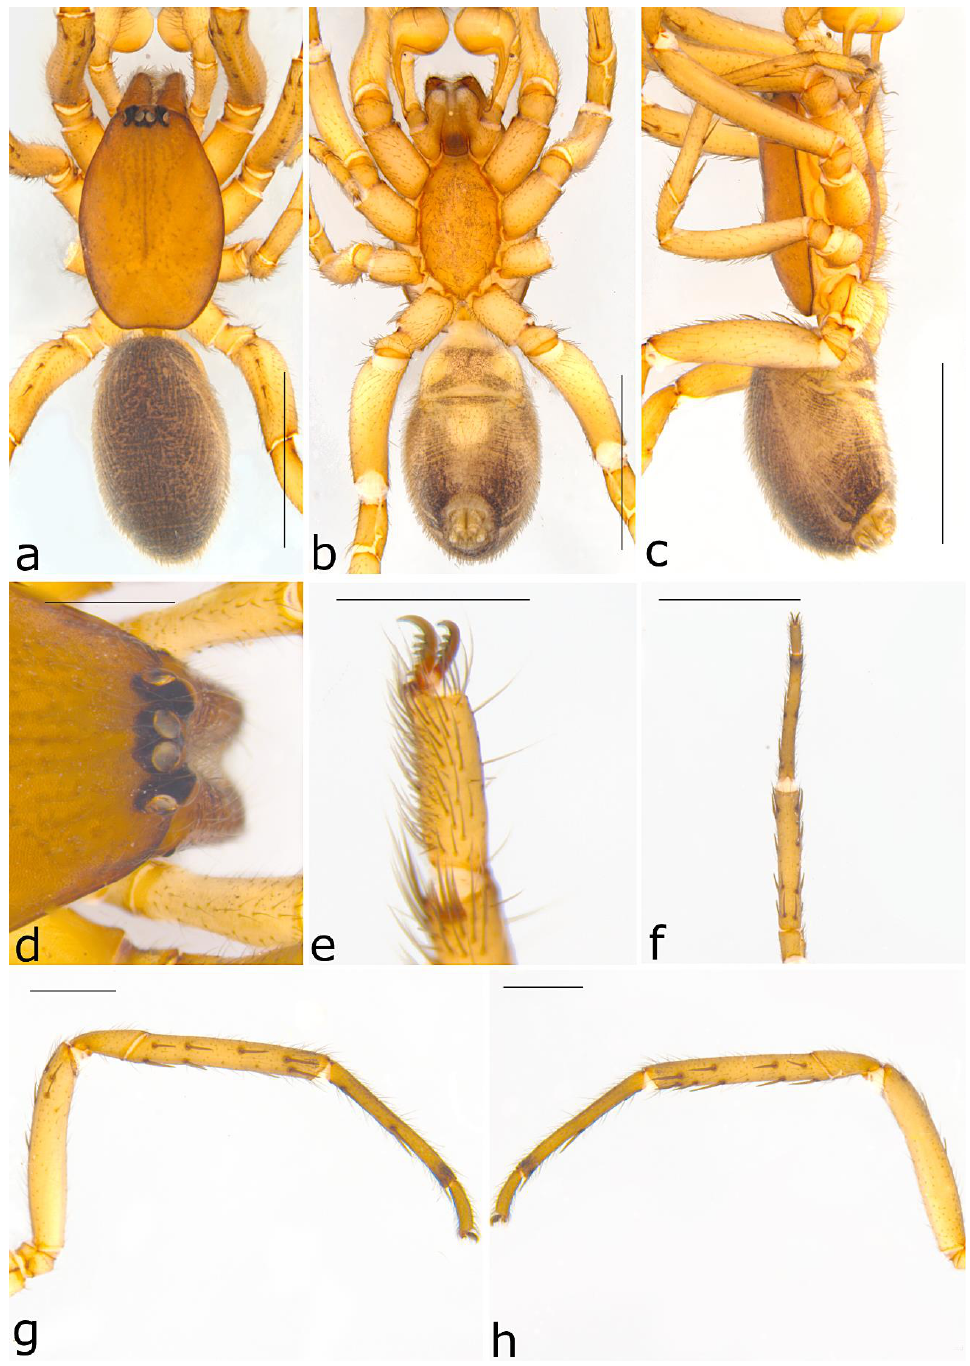
Figure 73. Ariadna woinarskii sp. nov. ♂ holotype (SAMA NN31200) from Kangaroo Island (SA): ( a ) habitus, dorsal view; ( b ) same, ventral view; ( c ) same, lateral view; ( d ) eyes, dorsal view; ( e ) left metatarsus IV, preening comb, retrolateral view; ( f ) left leg I, ventral view; ( g ) same, prolateral view; ( h ) same, retrolateral view. Scale bars ( a – c ) = 2 mm, ( d , e ) = 0.5 mm and f – h = 1 mm. Pedipalp: Tibia 0.5 long, 0.3 wide; cymbium 0.5 long, 0.3 wide. Pedipalp tibia rect- angular, with ventral indentation. Cymbium rounded rectangular and the bulb globular, with apical PAE and RAE. The embolus originates retrolaterally from the bulb, the mid portion is broad until around three quarters of the length of the embolus, where there is a brief prolateral expansion, from which it tapers apically to the tip; embolus tip is sinuous (Figure